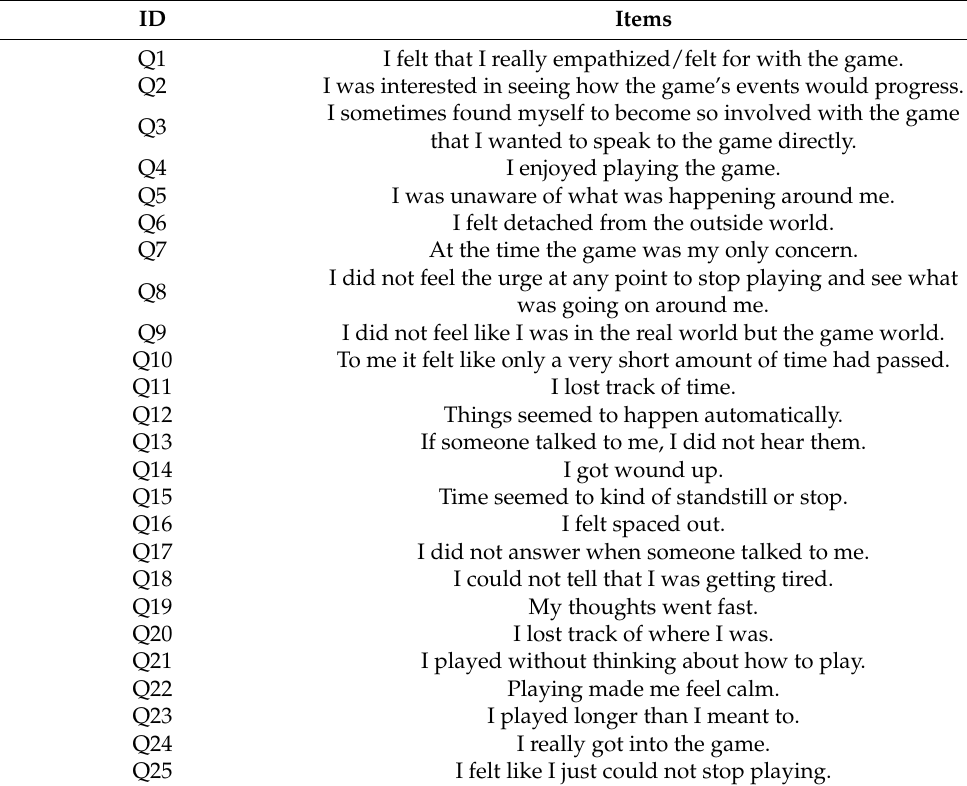
Table 8. Questionnaire